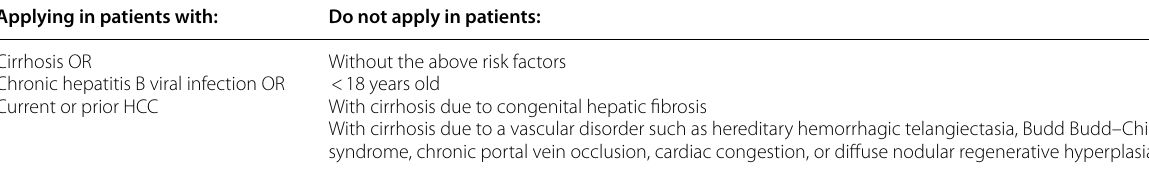
Table 1 Inclusion and exclusion criteria for LI-RADS categorization [7] Applying in patients